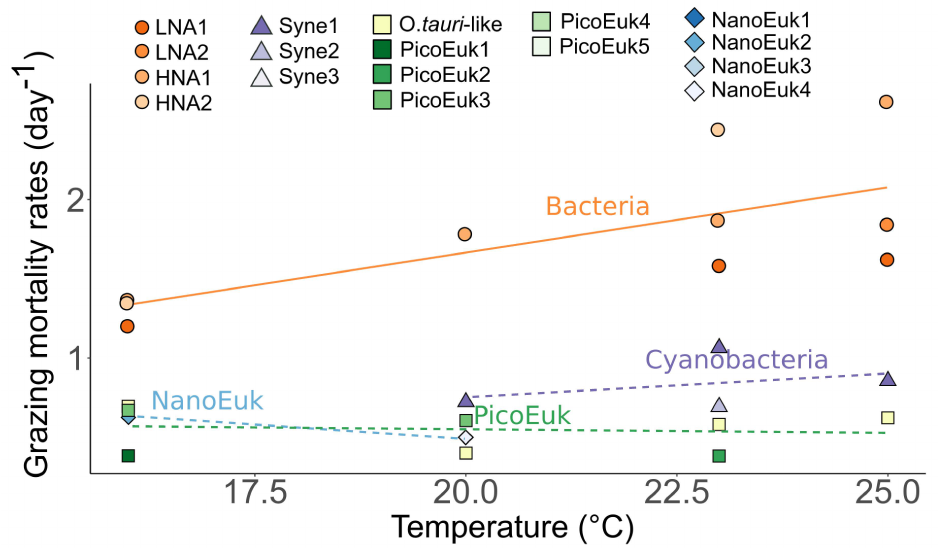
Figure 5. Grazing mortality rates of bacteria (shade of orange circles, full line indicates significant Spearman correlation with p -value < 0.05), cyanobacteria (shade of purple triangles), PicoEuk (shade of green squares), and NanoEuk (shade of blue diamonds) for eukaryotic pico- and nanophytoplankton groups as a function of water temperature. Dashed lines indicate non-significant relationships.